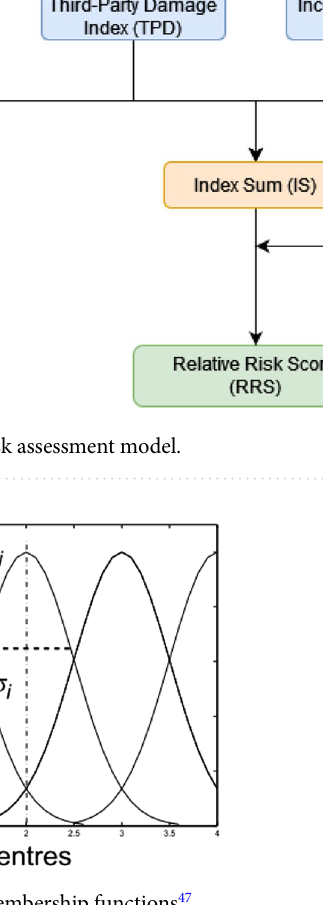
Figure 2. Gaussian membership functions 47